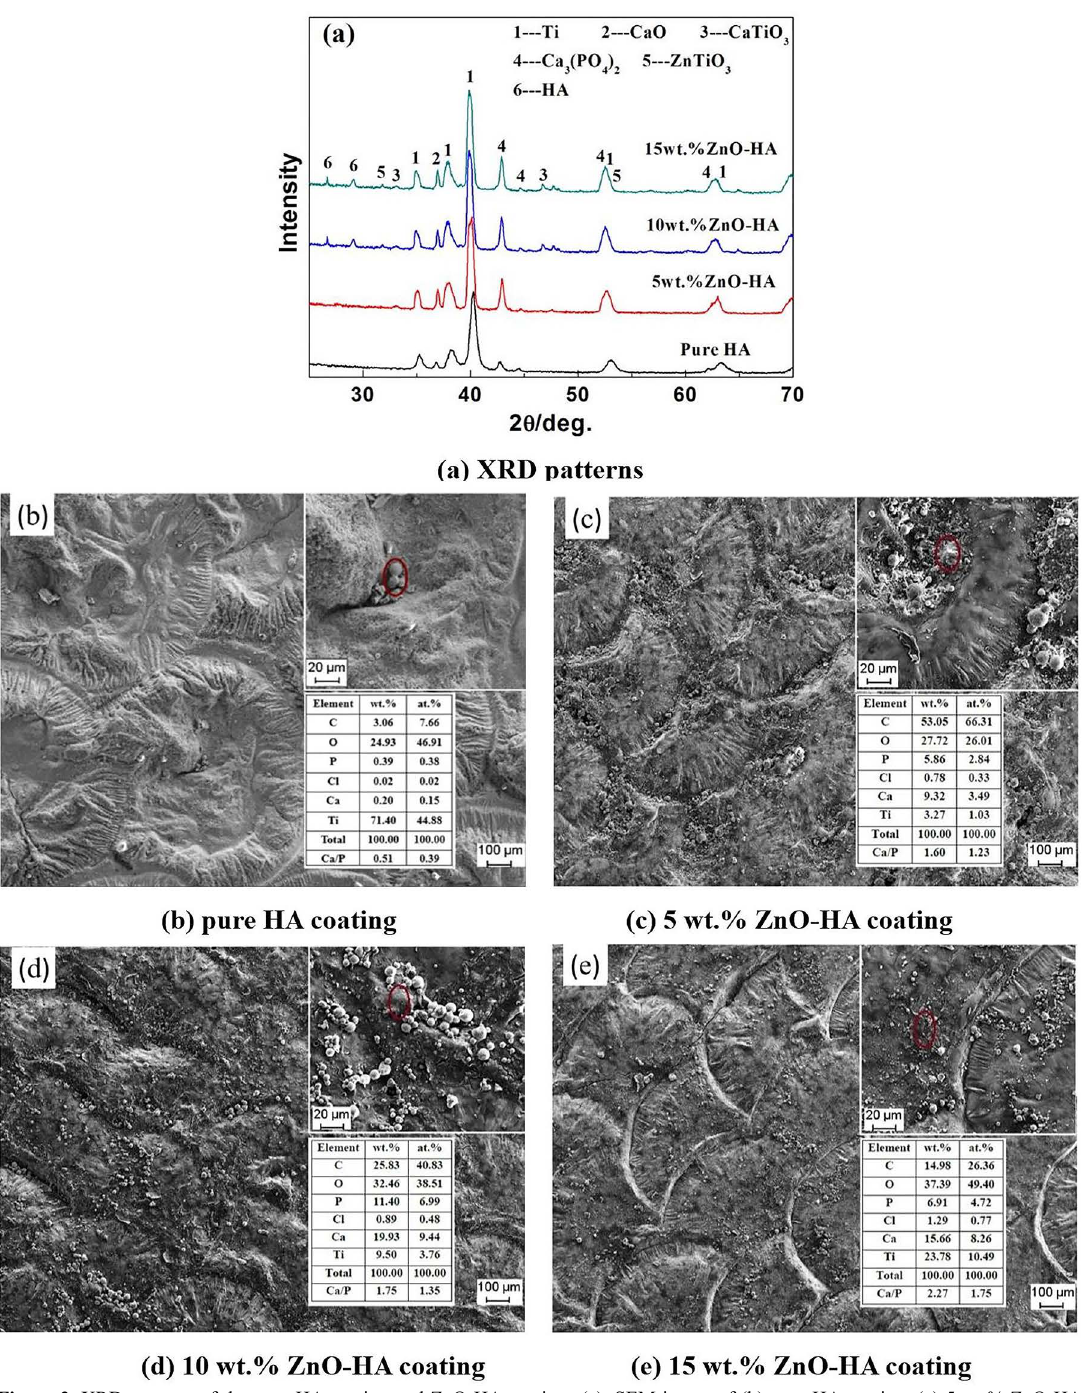
Figure 3. XRD patterns of the pure HA coating and ZnO-HA coatings (a), SEM image of (b) pure HA coating, (c) 5 wt.% ZnO-HA coating, (d) 10 wt.% ZnO-HA coating, and (e) 15 wt.% ZnO-HA coating after immersion in SBF for 14d . (The insets are SEM views with higher magnification and EDS analysis